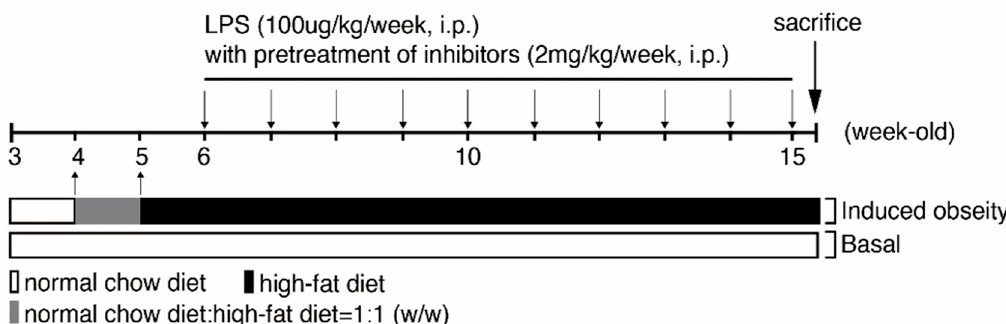
Figure 1. Model of obese kidney fibrosis with metabolic endotoxemia (OKF-ME). Mice were randomized into three groups: normal chow-fed control group (basal group), high-fat diet-fed group (HF group), and high-fat diet-fed group with lipopolysaccharides (LPS) treatment (HL group). The HL group was induced with LPS (100 µ g / kg / week intraperitoneal (i.p.) injection) as the working model of OKF-ME.